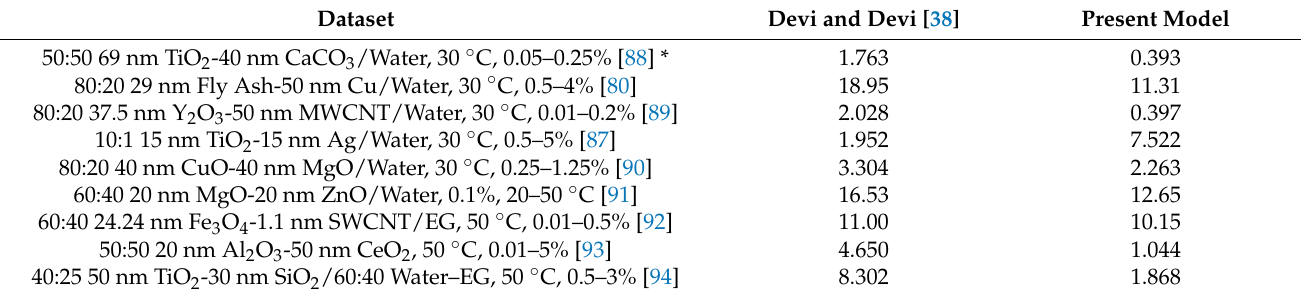
Table 7. Level of accuracy (%) of the best performing preexisting hybrid nanofluid model versus the present model. Dataset